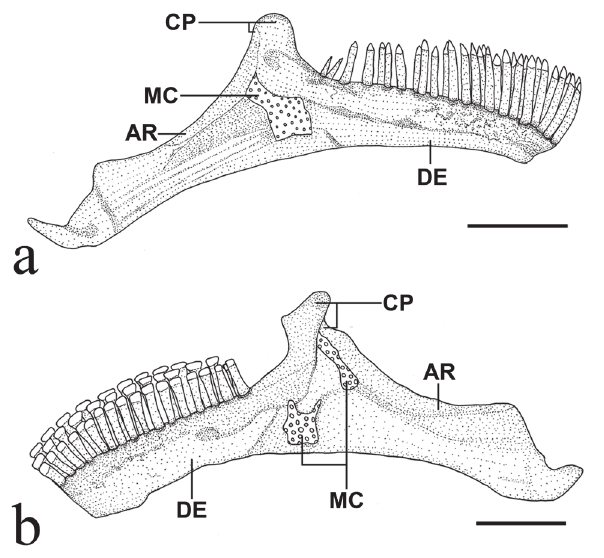
Fig. 11. Right lower jaw of ( a ) Trichomycterus diatropoporos , paratype, UFRGS 16237, 57.8 mm SL in lateral view and ( b ) T . poikilos , paratype, MCP 22699, 79.0 mm SL, in medial view. Abbreviations: AR, anguloarticular; CP, coronoid process; Fig. 12. Pelvic girdle of Trichomycterus diatropoporos , paratype, UFRGS 16237, 57.8 mm SL, dorsal